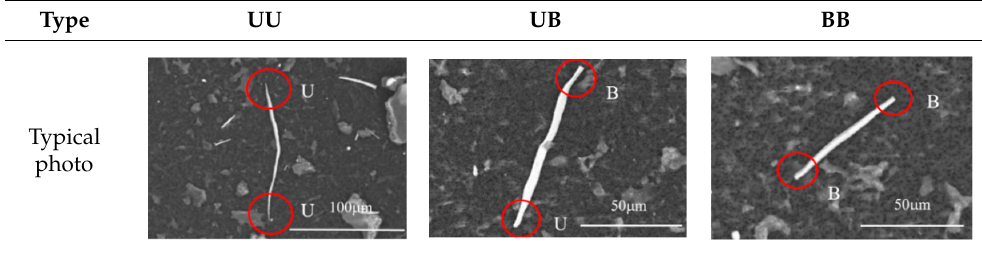
Table 5. Typical SEM images of elongated MnS inclusions with broken (B) and unbroken (U) edges in the steel samples after a completed EE.